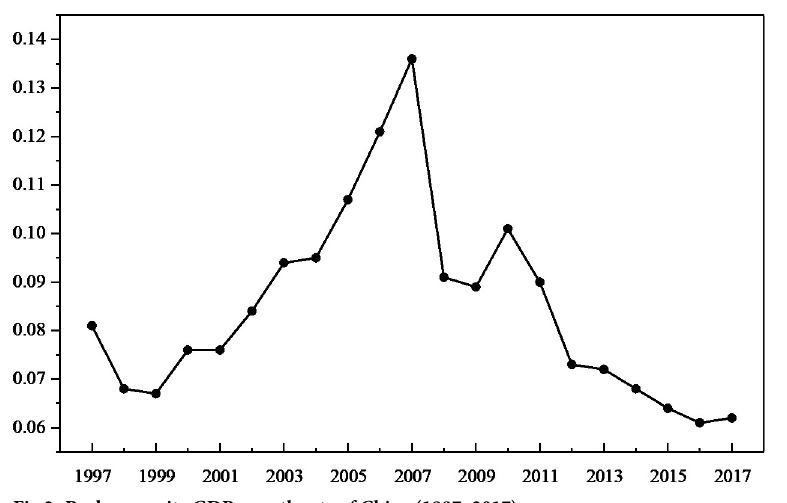
Fig 2. Real per capita GDP growth rate of China